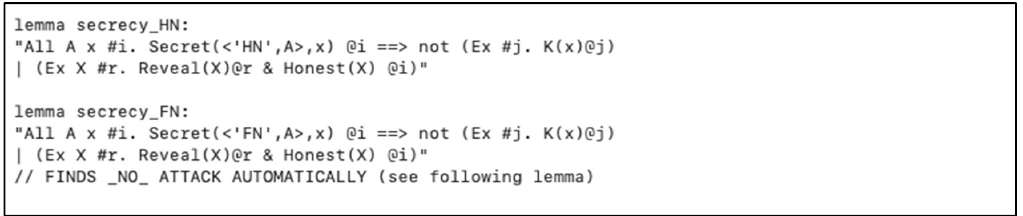
Figure 9. FN new parameters calculation and honesty verification.